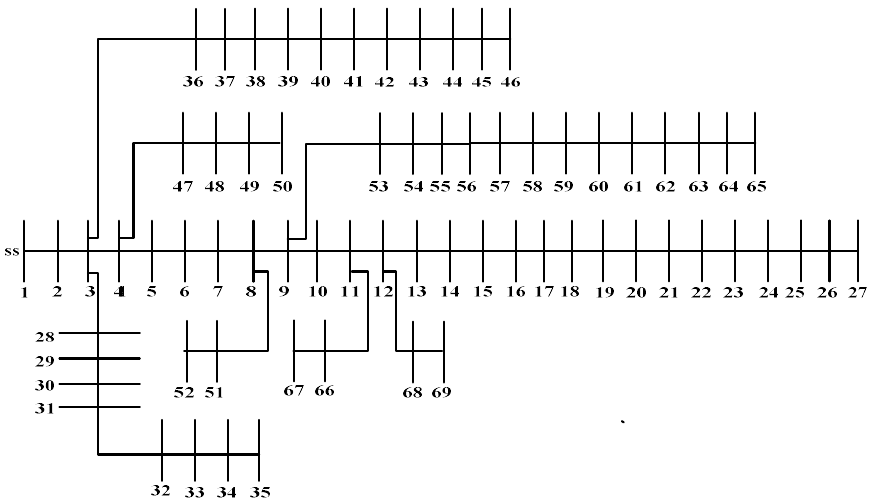
Figure 9. Single line diagram of IEEE 69-bus system.